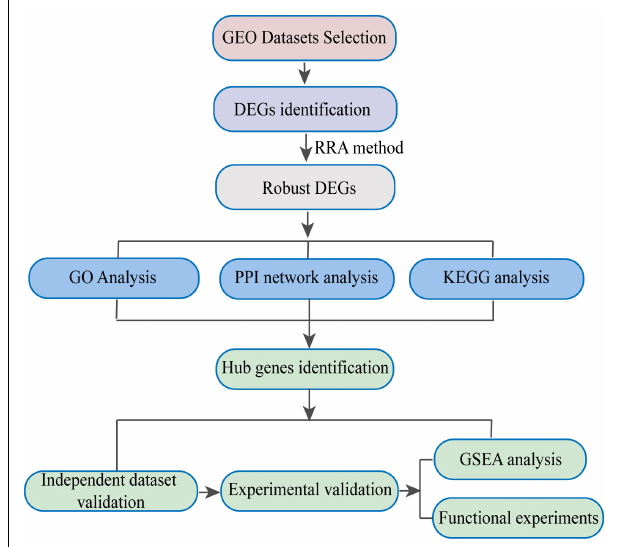
FIGURE 1 | Workflow of the present study. GEO, Gene Expression Omnibus; DEGs, Differentially Expressed Genes; RRA, Robust Rank Aggregation; PPI, Protein-Protein Interaction; GSEA, Gene Set Enrichment